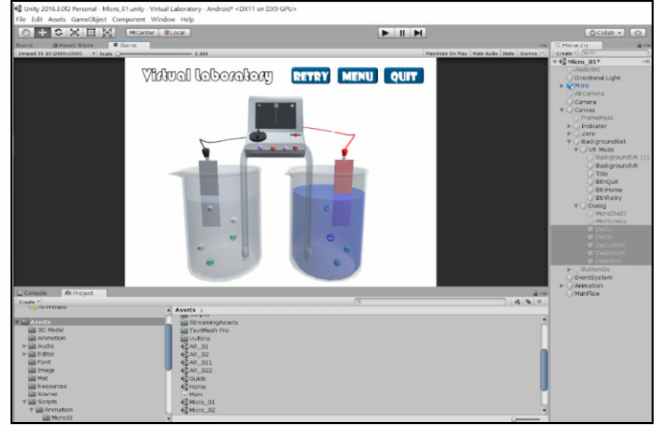
Figure 5. Designing the user interface of the virtual experiment using the Unity3D.